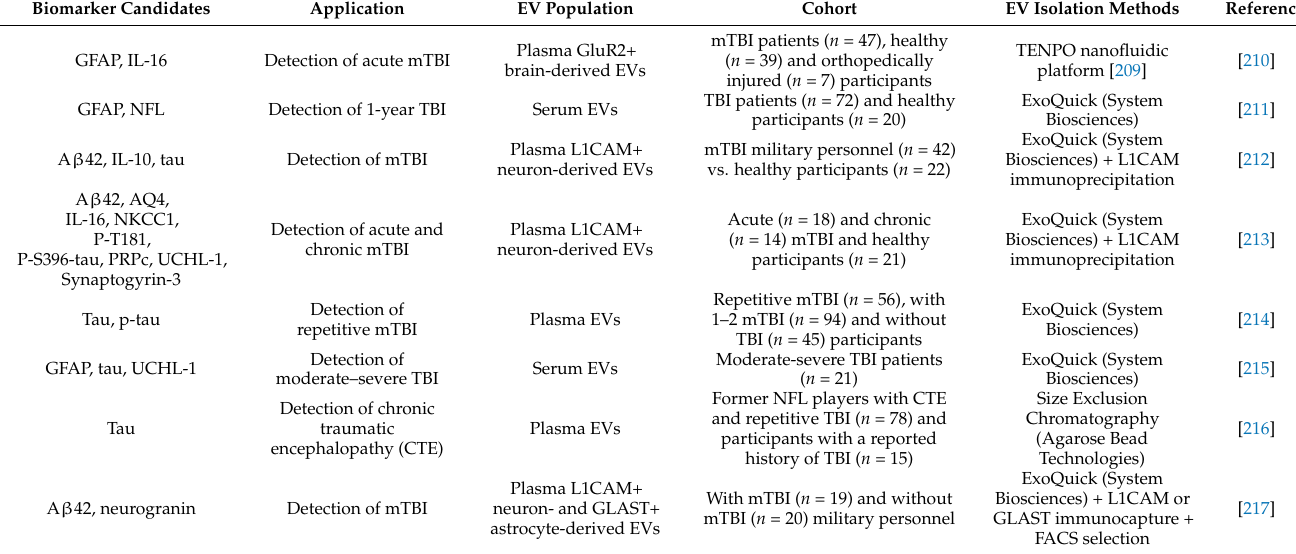
Table 3. EV biomarker candidates in